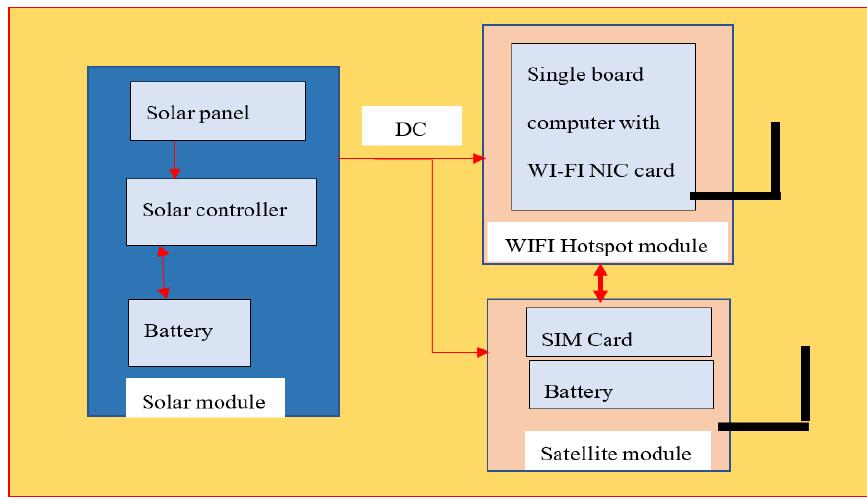
Figure 1. Hardware components of the proposed solar-supplied satellite access point.